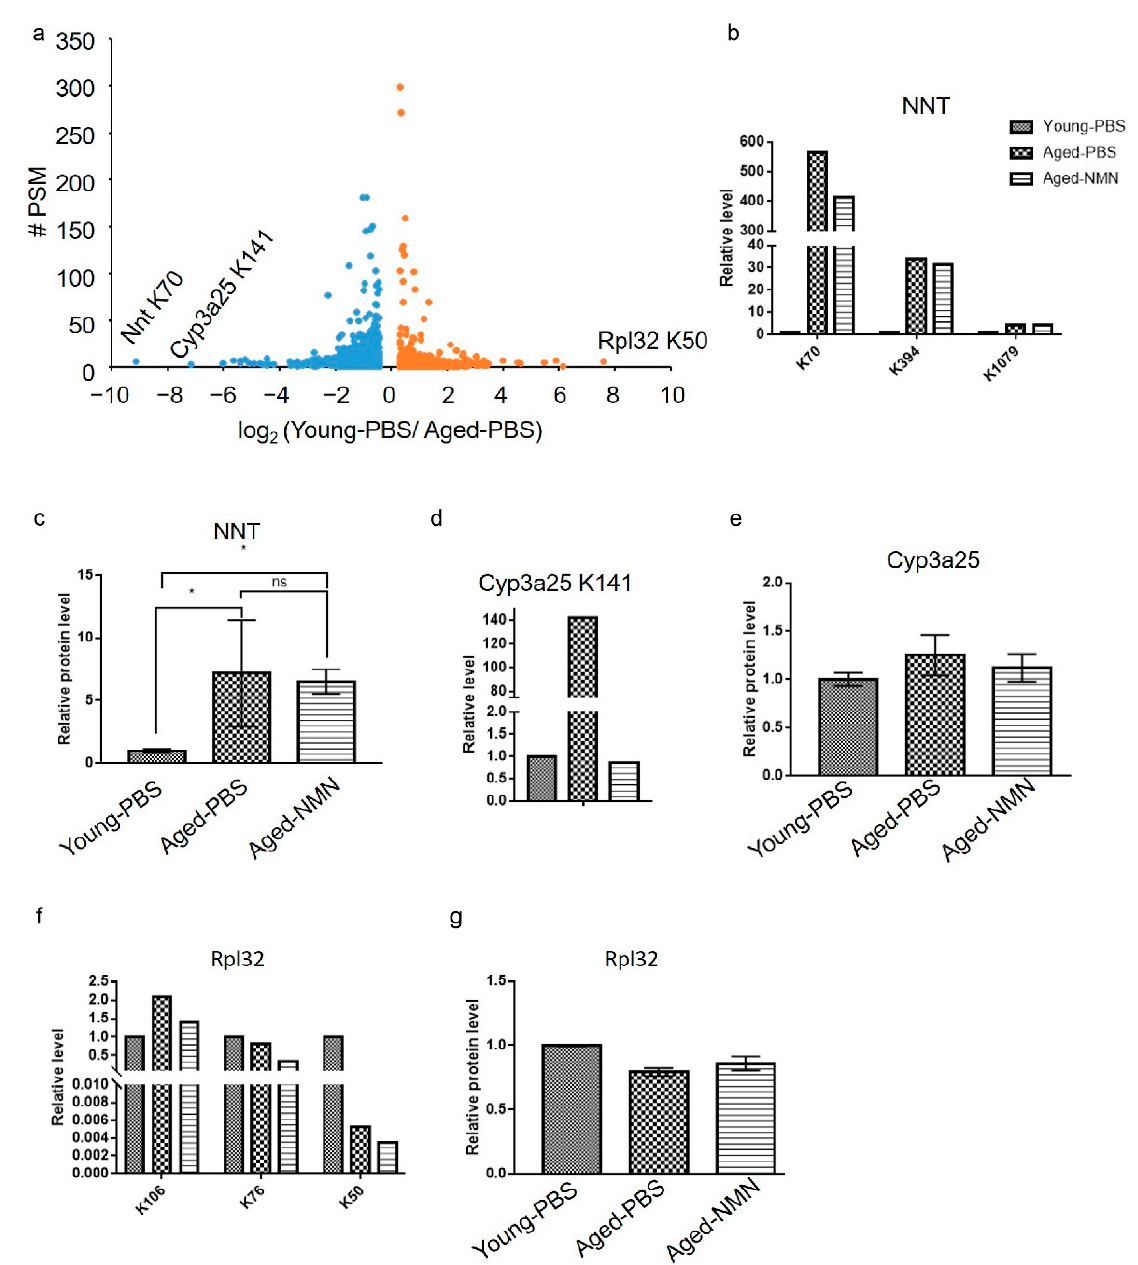
Figure 4. The fold changes distribution for acetylated peptides. ( a ) The volcano map showed that the acetylation level in NAD(P) transhydrogenase (NNT) at K70 was increased, whereas that in 60S ribosomal protein L32 (RPL32) at K50 was reduced in aged mice. PSM: peptide spectral matches. ( b ) The relative intensities of acetylated peptides from NNT in young, PBS-treated and NMN-treated aged mice. ( c ) The relative level of NNT protein quantitated with proteomic analysis. Data were expressed as mean ± SD, n = 4, * p < 0.05, ns: no significance. ( d ) The relative intensity of an acetylated peptide on Cyp3a25 in young, PBS-treated and NMN-treated aged mice. ( e ) The relative level of Cyp3a25 protein quantitated with proteomic analysis. Data were expressed as mean ± SD, n = 4. ( f ) The relative intensity of an acetylated peptide on RPL32 at K50 in young, PBS-treated and NMN-treated aged mice. ( g ) The relative level of Rpl32 protein quantitated with proteomic analysis. Data were expressed as mean ± SD, n = 4. Young-PBS: young mice treated with PBS, Aged-PBS: aged mice treated with PBS, Aged-NMN: aged mice treated with NMN.